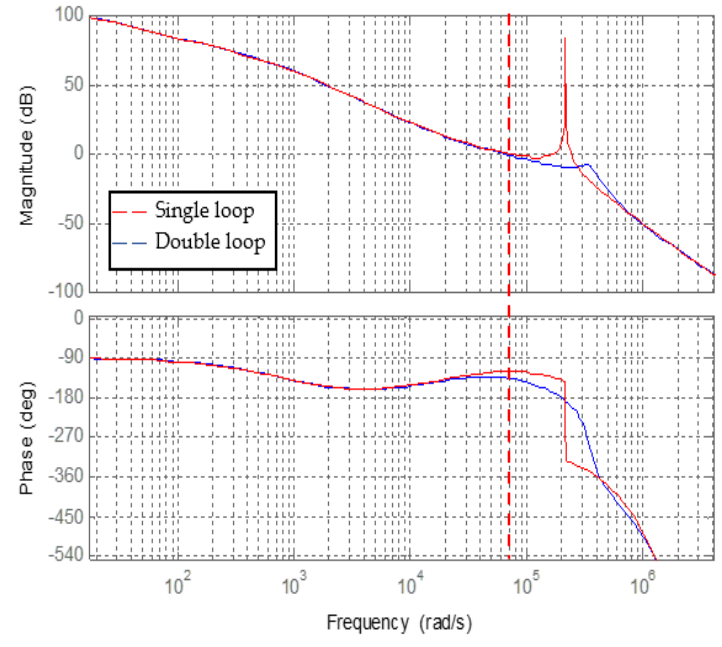
Figure 13. Bode plot of the single loop and double loop.